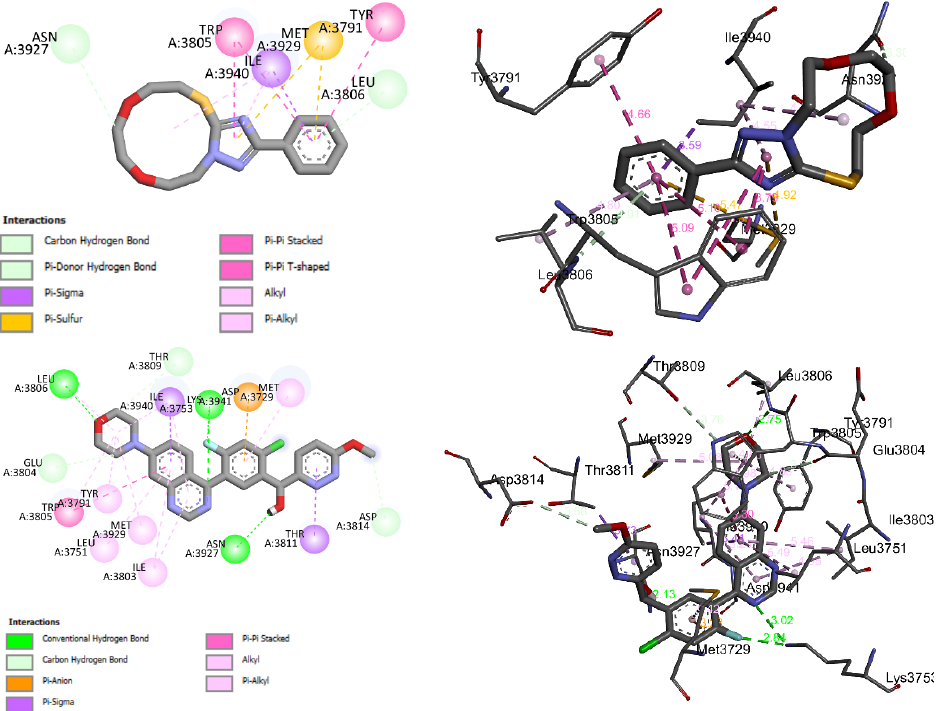
Figure 13. 2D and 3D closest interactions between the active site residues of DNA-PK and 3 ( up ) and the original docked ligand OLig ( bottom ).